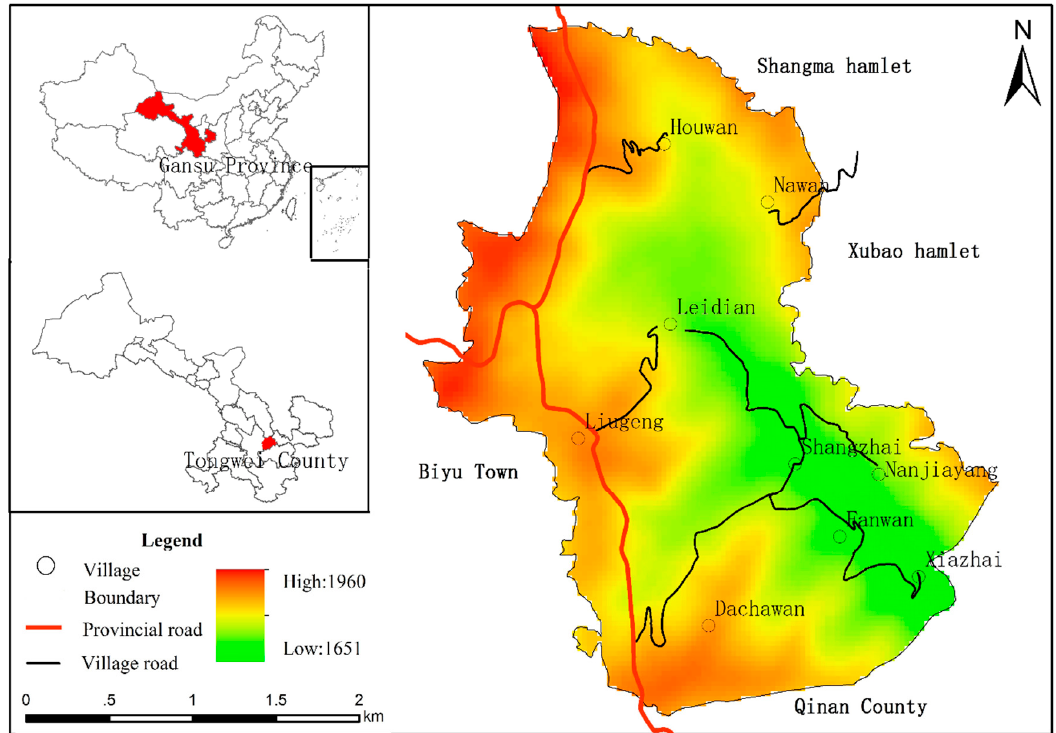
Figure 1. Map of the study area.